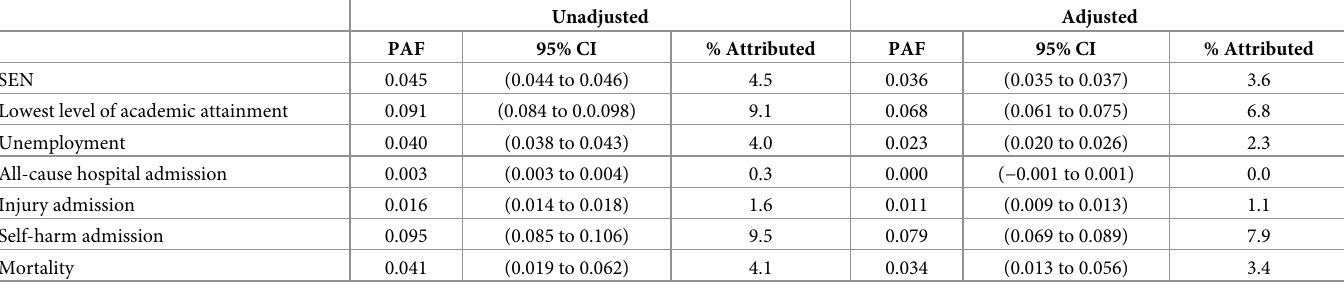
Table 3. PAFs for looked after